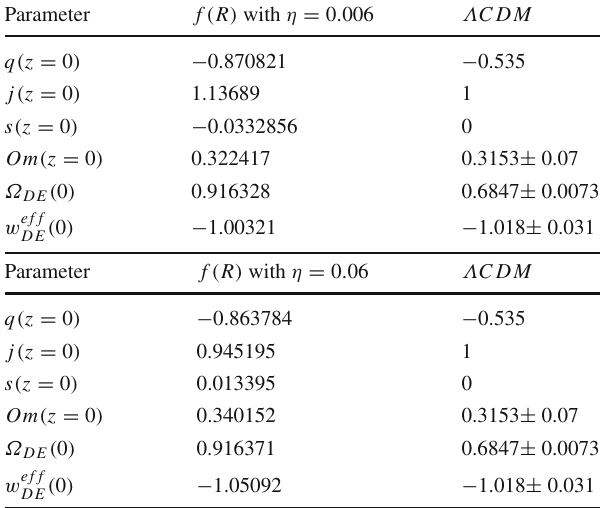
Table 2 Cosmological parameter values at the present epoch for Q > 0, with different η and α = 0 .